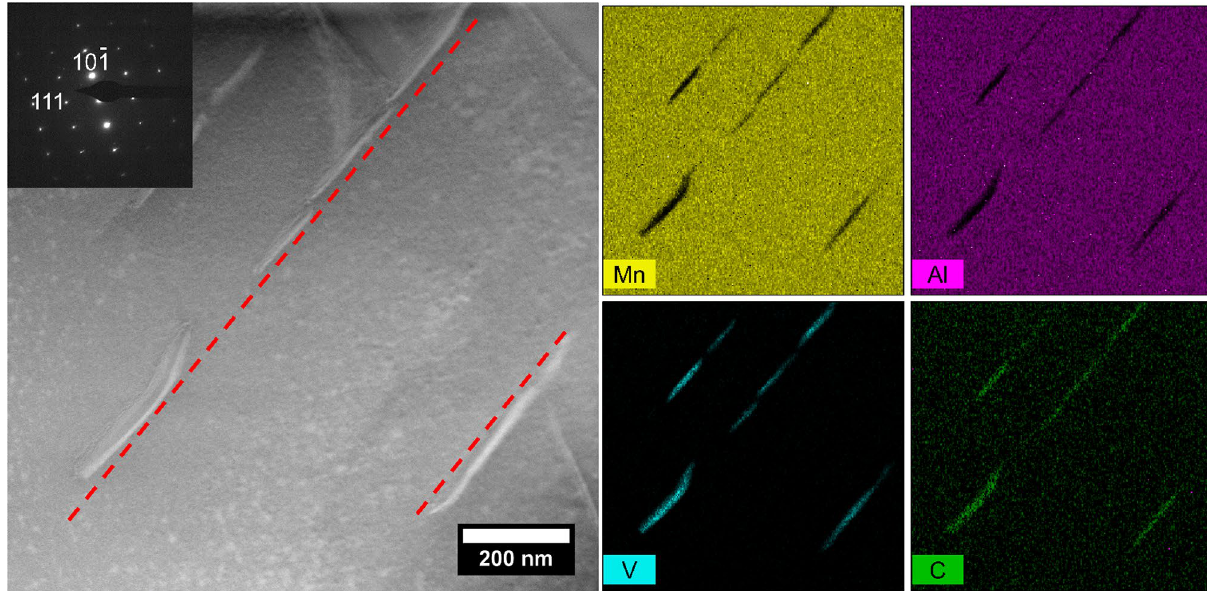
Figure 2. STEM image of the Mn 55 Al 45 C 2 (VC) 1 sample, showing V-, C-rich precipitates forming in the τ-phase. The inset shows an electron diffraction pattern, indexed with the τ-phase oriented in the[1–21] zone axis. The red line indicates the [103]